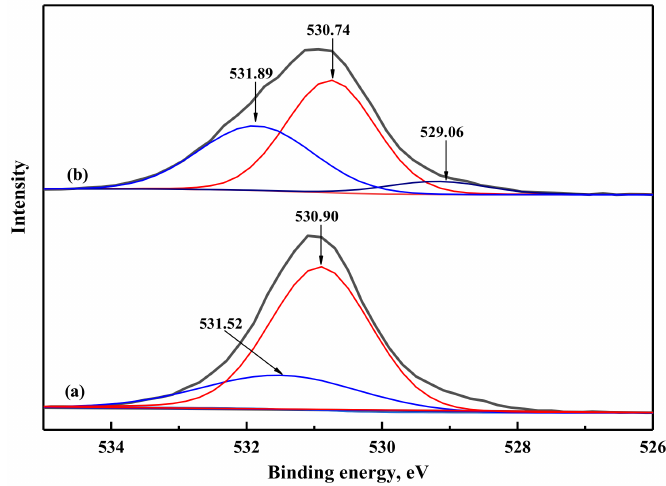
Figure 9. ( a ) O1s XPS spectra of azurite; ( b ) O1s XPS spectra of azurite +